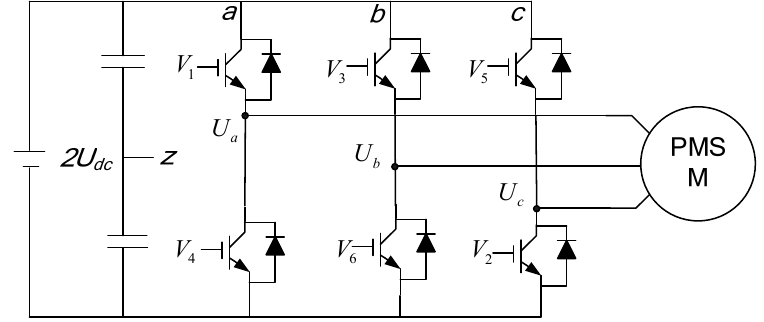
Figure 6. Typical topology of three ‐ phase PMSM power system.